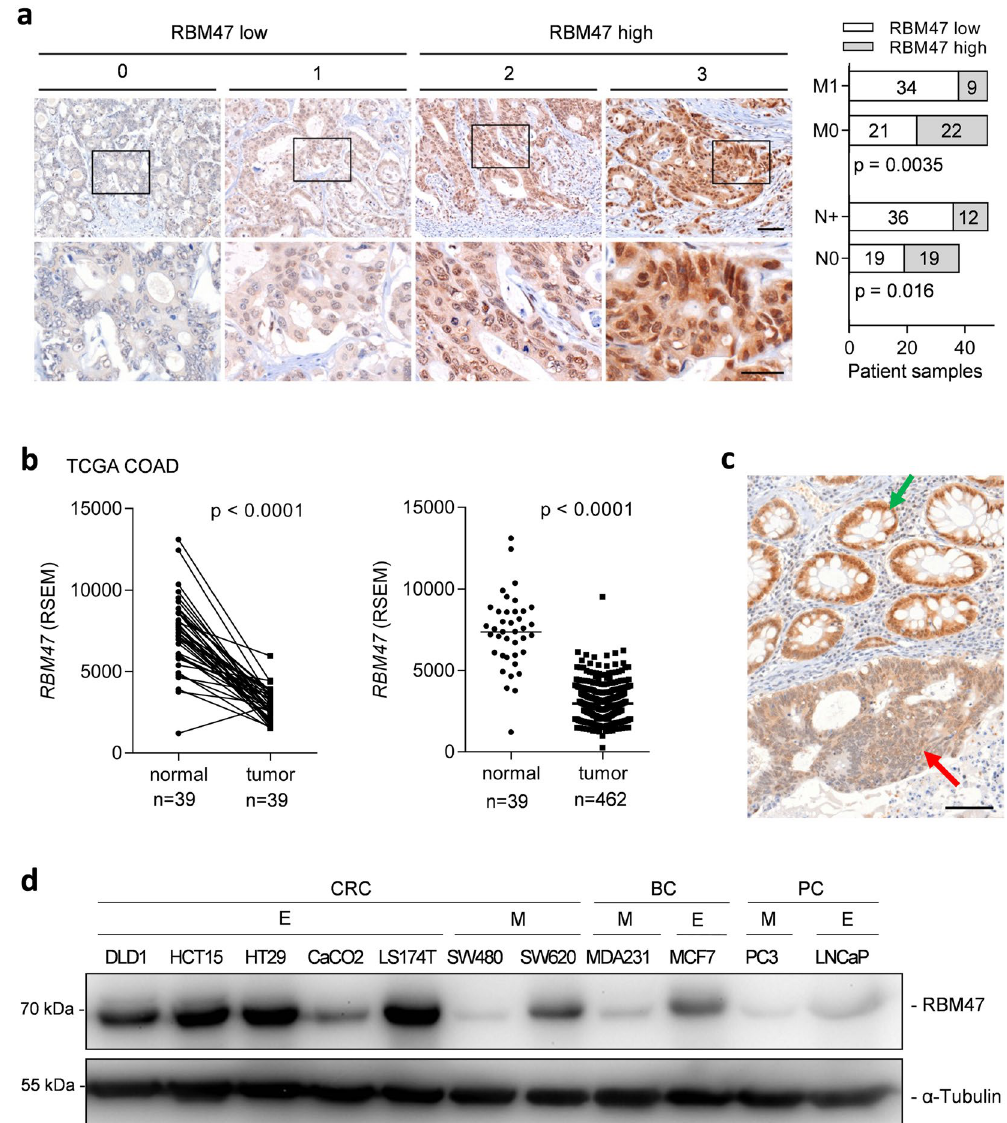
Figure 4. Low expression of RBM47 protein is associated with metastasis and positive nodal status in CRC patients ( a ) Association of RBM47 protein expression with liver metastasis (M1) and nodal metastasis (N + ) in the M0/M1 patient collection (N = 86). Left panel: representative IHC staining results of patient samples with staining scores. Right panel: quantification of IHC staining and association with metastasis (M0 – no metastases present, M1 – liver metastases present) and nodal status (N0 – no tumor cells present in lymph nodes, N + - tumor cells present in lymph nodes). The scale bar in low magnification images (upper part) represents 100 μ m and the bar in high magnification images (lower part) represents 50 μ m. ( b ) Expression of RBM47 mRNA in normal colonic tissue and colon tumors in the TCGA COAD dataset. In the left panel expression of RBM47 in paired samples from the same patient are shown and in the right panel all samples are shown. ( c ) Exemplary IHC results showing expression of RBM47 protein in a colon cancer (red arrow) and adjacent normal colonic mucosa (green arrow). The scale bar represents 100 μ m. ( d ) Immunoblot analysis of RBM47 expression in a cell line panel consisting of epithelial-like (E) and mesenchymal-like (M) colorectal (CRC), breast (BC), and prostate (PC) cancer cell